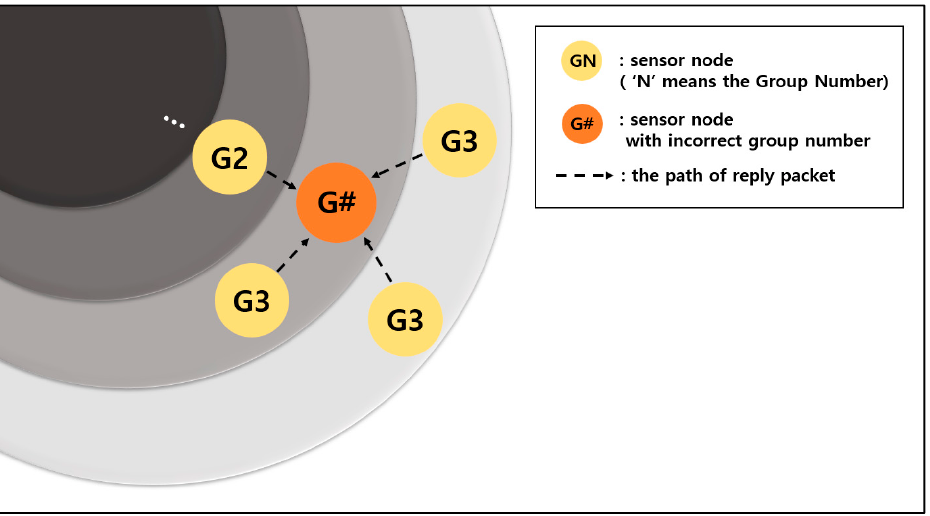
Figure 16. Incorrect group number resetting scenario.